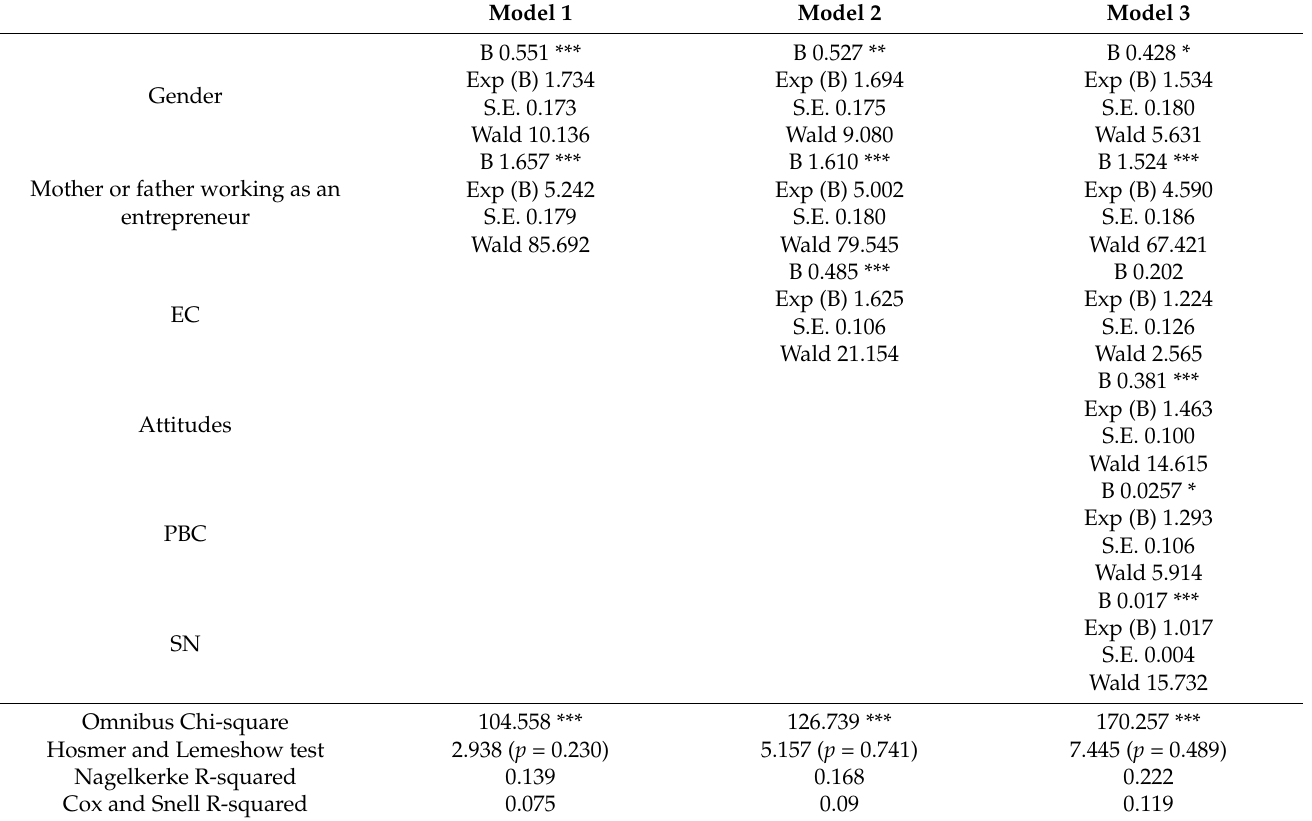
Table 4. Results from the logistic regression analysis.